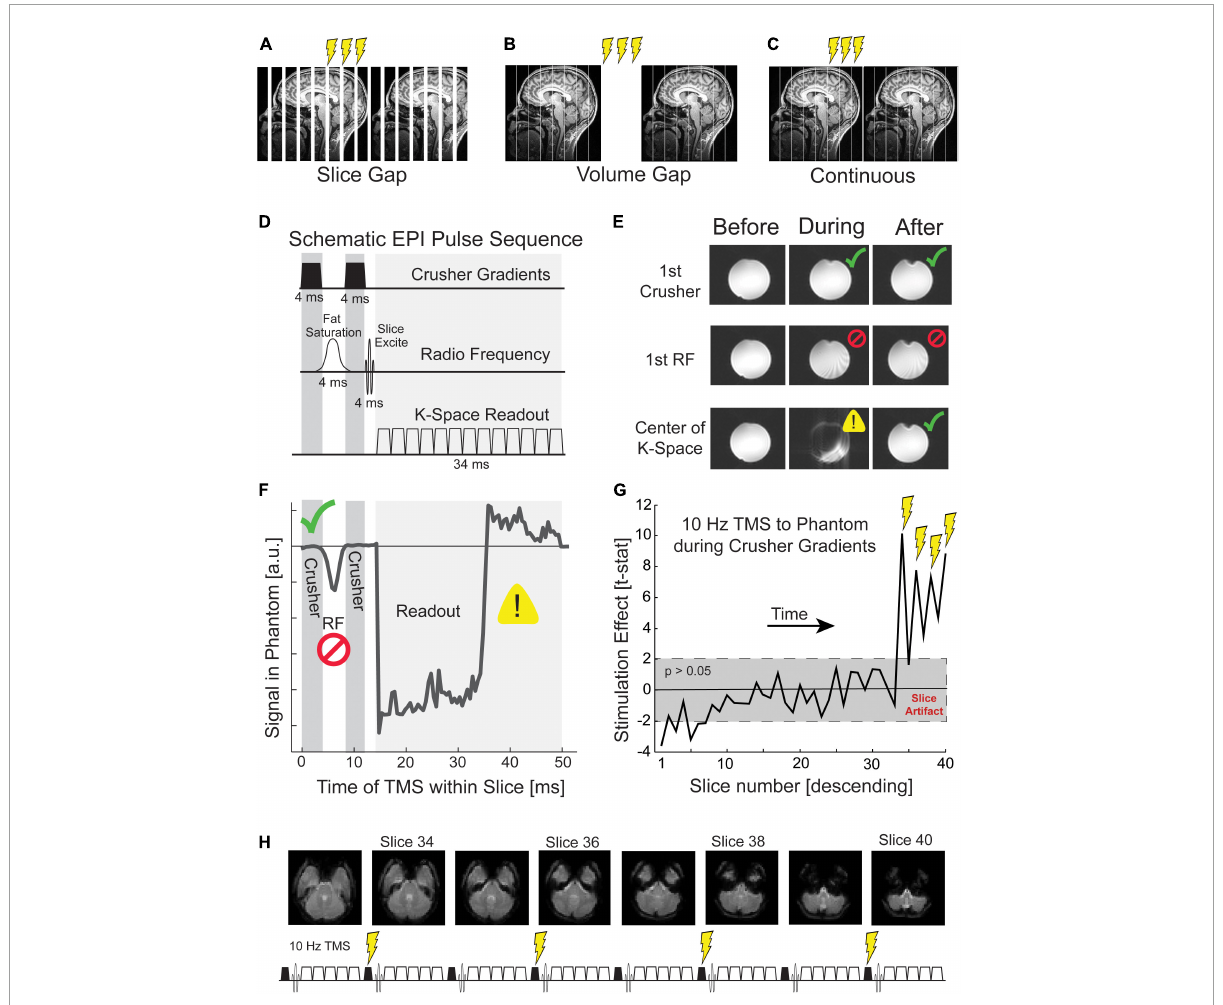
FIGURE2 Targeting crusher gradients with TMS in continuous fMRI. TMS pulses during fMRI can be delivered (A) in imposed gaps between slices, (B) in imposed gaps between volumes, (C) or continuous with fMRI acquisition. (D) An MRI slice comprises three epochs: crusher gradients, radio frequency excitation, and k-space readout. The crusher and readout gradients are depicted symbolically. Actual gradients are administered on all three gradient channels and have differing timing depending on the intended use. (E) TMS that occurs during each of these three epochs generates different artifacts. Before refers to the volume (i.e., set of EPI slices) acquired before TMS, during to the volume of TMS, and after to the volume following TMS. TMS during the first crusher gradient shows minimal distortion (green check; top row), TMS during the first RF pulse causes persistent disruption (middle row; red cross), and TMS during k-space readout disrupts only the current slice (bottom row; yellow warning). (F) TMS incremented throughout the acquisition of a slice reveals unique signal disruption such that the temporal relationships between the three epochs of slice acquisition can be visualized. Further details are given in the Supplementary material . (G) TMS during the first crusher gradient produces slice artifacts that are not visible to the naked eye but are detectable statistically. The gray box depicts a t -test with a p -value greater than 0.05. (H) Our continuous TMS-fMRI paradigm delivered four pulses of TMS during the crusher gradients of slices 34, 36, 38, and 40. These slices correspond to the acquisition of the cerebellum and temporal